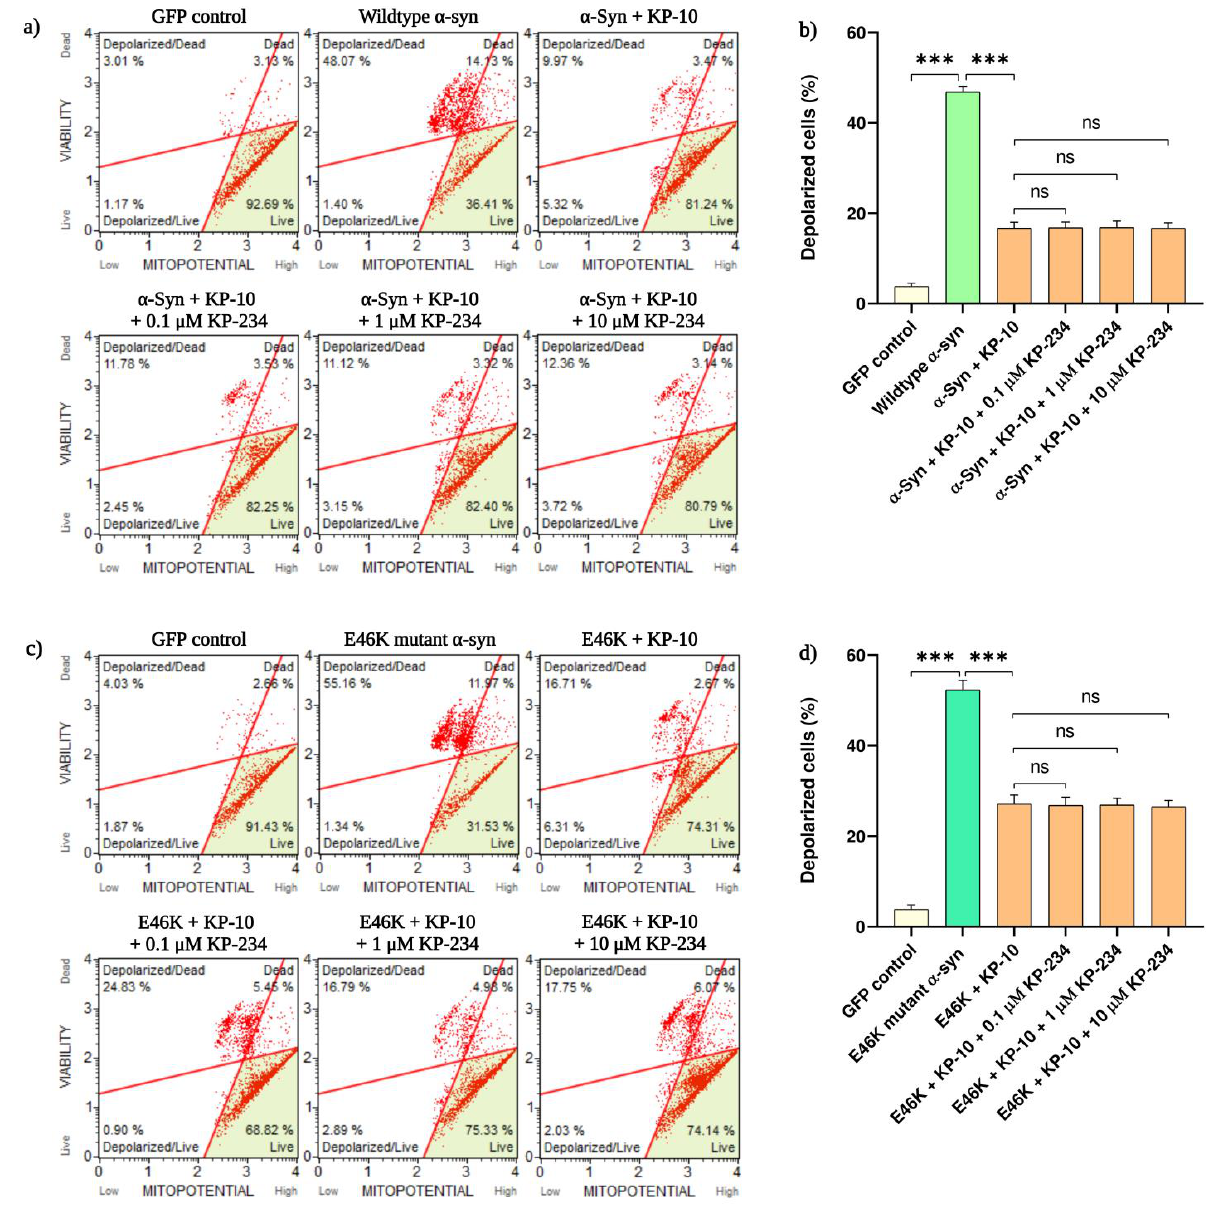
Figure 2. The effect of kisspeptin-10 (KP-10) on human wild-type or E46K mutant α -synuclein ( α -syn)-mediated mitochondrial depolarization in cholinergic-like neurons. Differentiated neurons overexpressing human wild-type or E46K mutant α -syn were exogenously subjected to KP-10 (0.1 µ M) either alone or in concert with KP-234 (0.1 to 10 µ M). The induction of mitochondrial membrane depolarization was measured using the Muse automated cell analyzer. ( a , c ) Representative plots of experiments executed for the detection of mitochondrial depolarization showing depolarized live ( lower left : 7-AAD negative, mitopotential negative), depolarized dead ( upper left : 7-AAD positive, mitopotential negative), non-depolarized live ( lower right : 7-AAD negative, mitopotential positive), and non-depolarized dead ( upper right : 7-AAD positive, mitopotential positive) cells. The quantification of total depolarized cells presented in ( b , d ) is representative of mean values ± SEM from three independent biological replicates performed in triplicates. While the α -syn-mediated dissipation of mitochondrial membrane potential by both human wild-type ( a , b ) and E46K mutant ( c , d ) α -syn was substantially reverted by KP-10 (*** p < 0.001), co-administrations with KP-234 had a non-existent influence on this alleviative effect. Statistical significance was defined as p -value less than 0.001 (*** p <